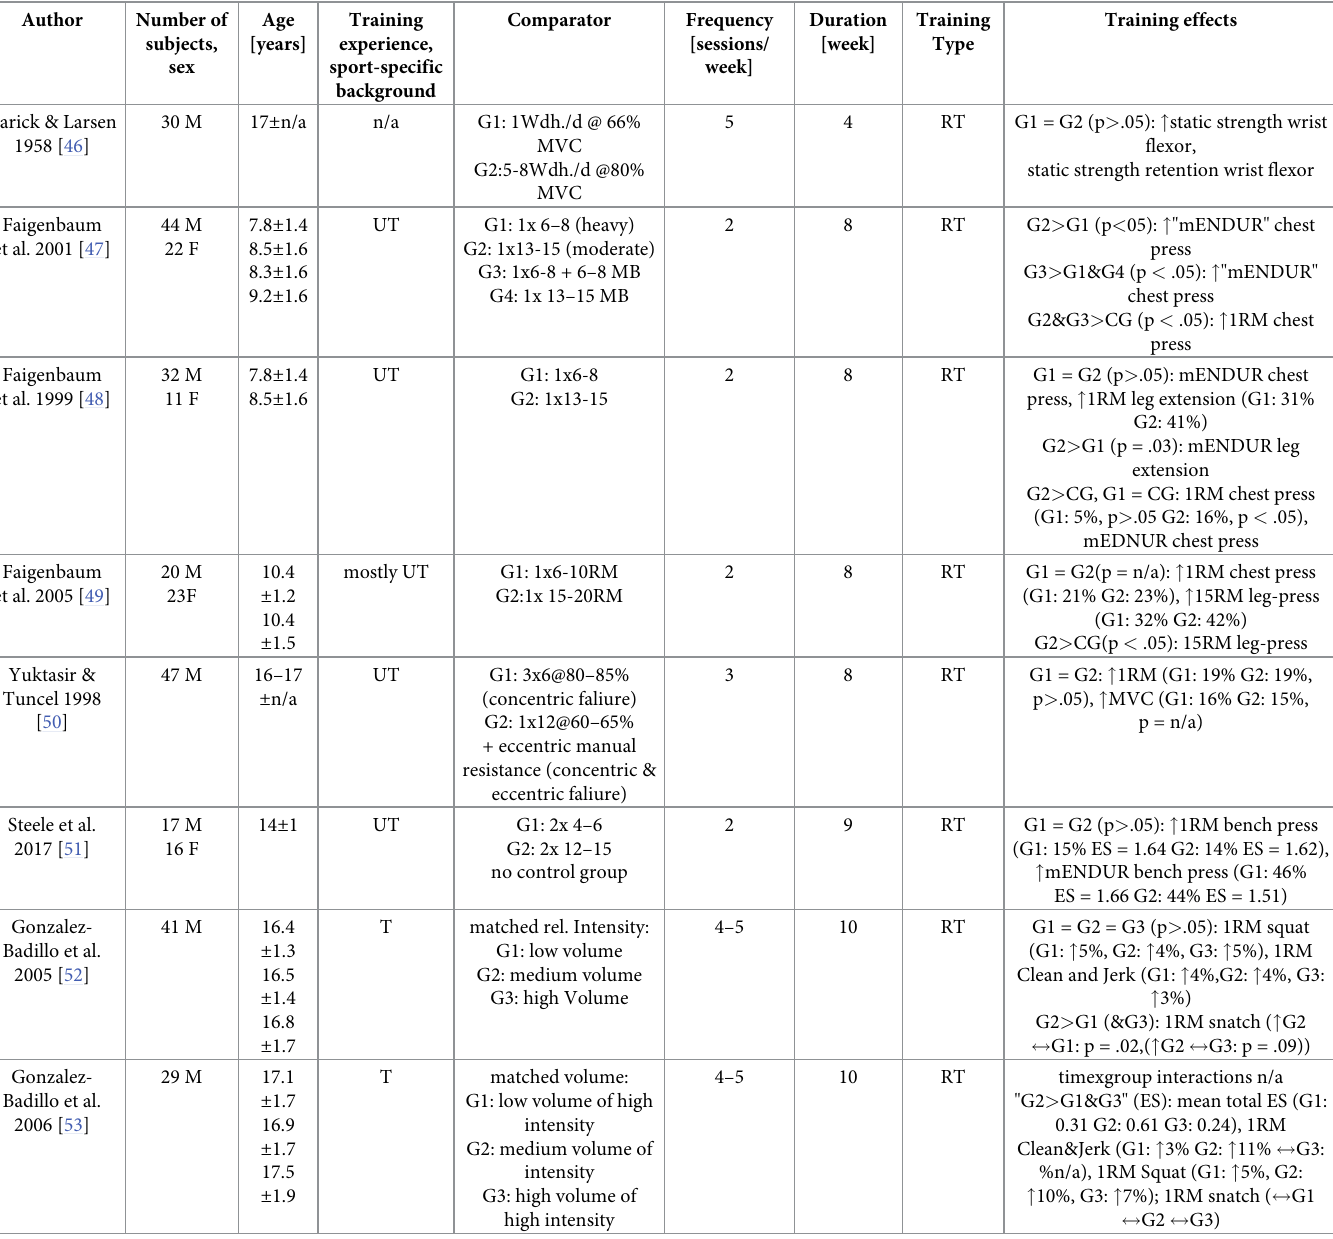
Table 3. Influence of the moderating variables ‘training intensity and volume’ on resistance training induced improvements in components of physical